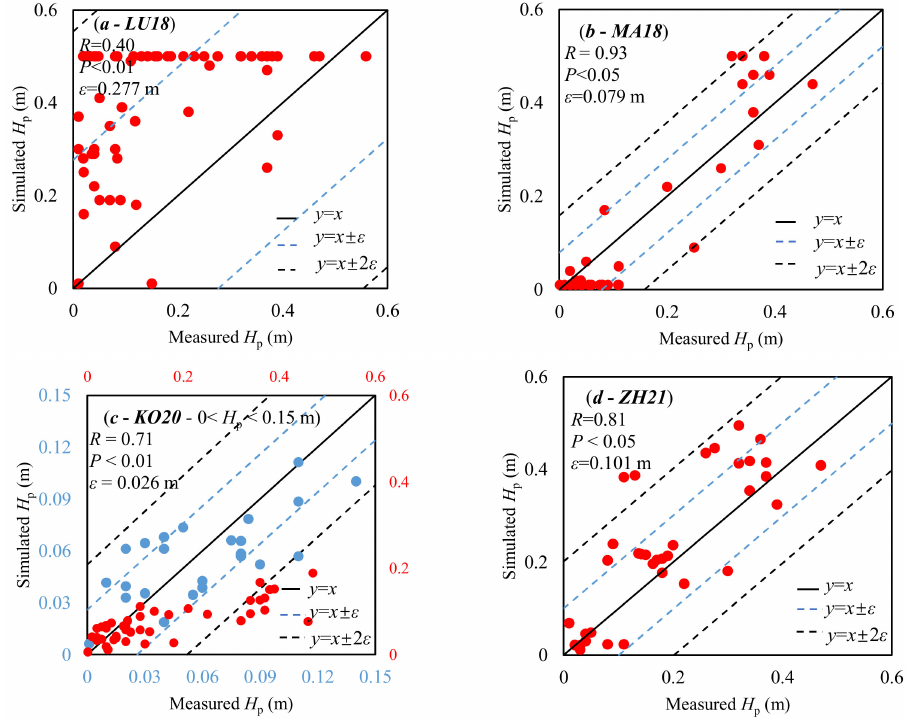
Figure 3. Comparison between the in situ measured H p and the estimations by the above four algorithms under clear sky conditions. Panel ( a ) is the results for the LU18 algorithm, ( b ) for the MA18, ( c ) for KO20 and ( d ) for ZH21. The blue points in panel ( c ) denote the data within the range of 0–15 cm.